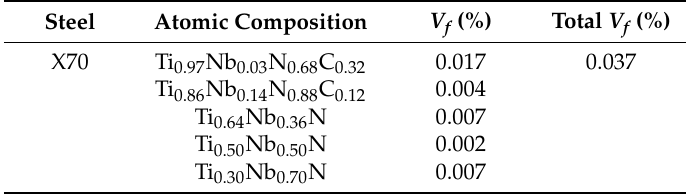
Table 7. QXRD large precipitate summary for X70 and TWX70